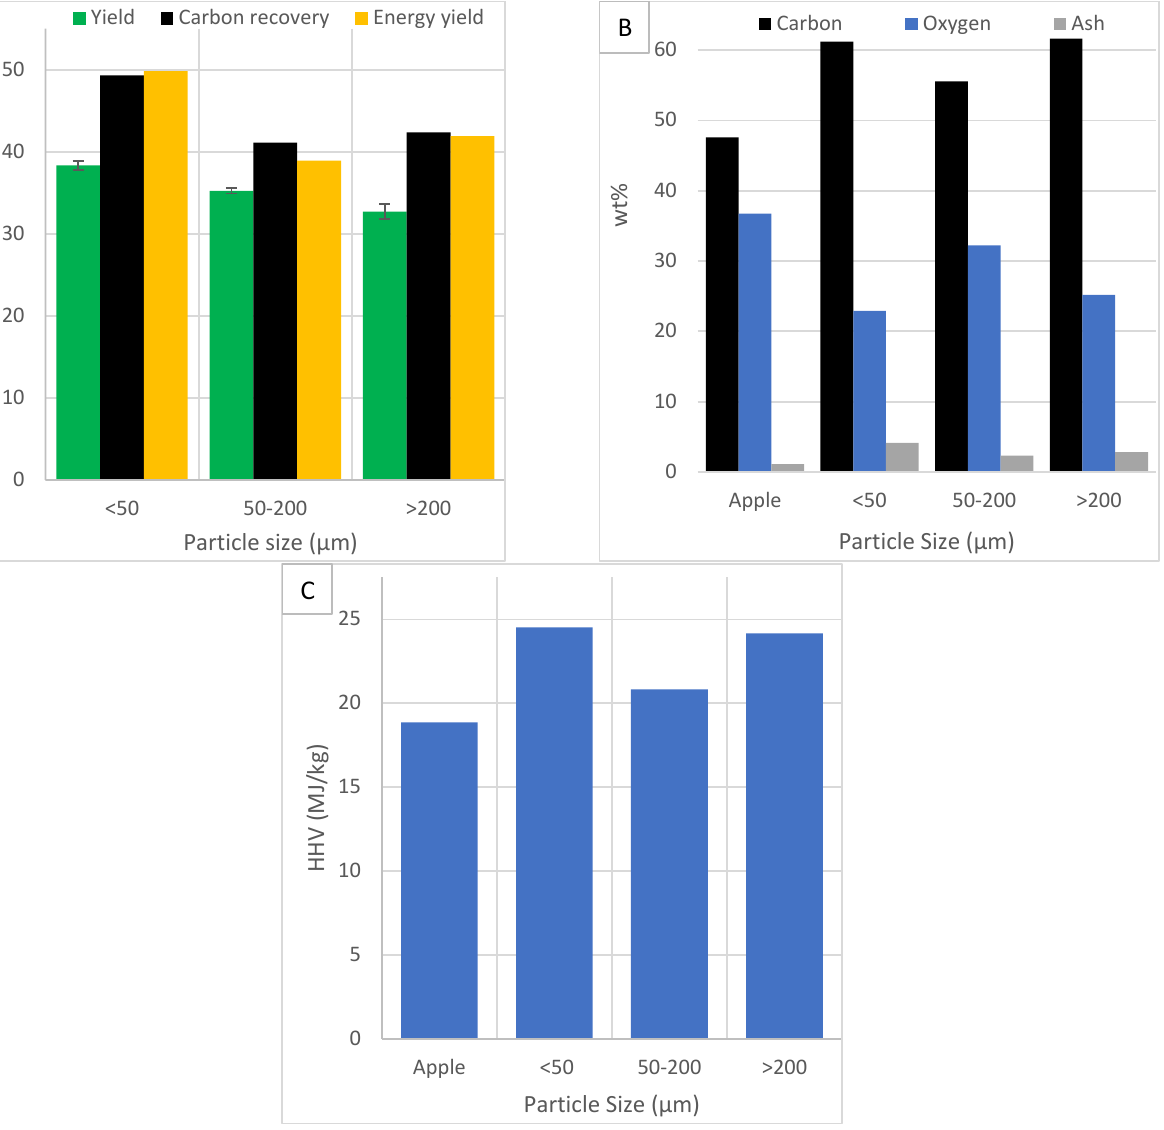
Figure 7. The effect of particle size on ( A ) HC yield, carbon recovery and energy yield, ( B ) carbon, oxygen and ash content and ( C ) HHV.